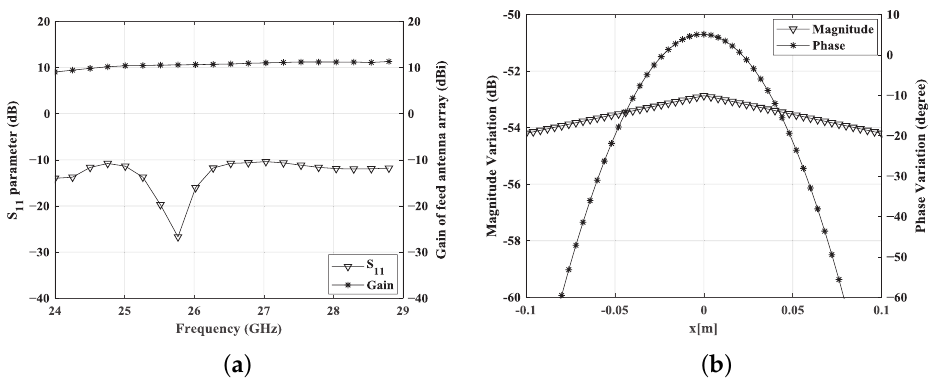
Figure 6. Performance of the 2 × 2 square patch array: ( a ) S 11 parameter and gain of the feeding antenna array and ( b ) magnitude and phase-variation distribution.